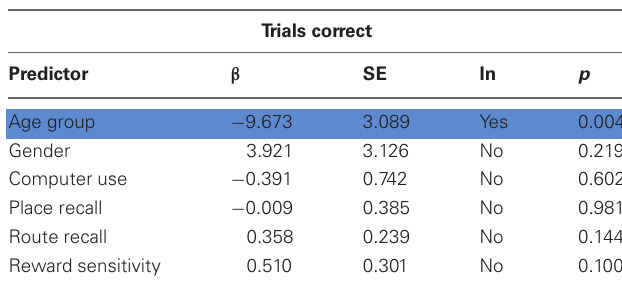
Table 1 | Results of stepwise regression analysis predicting trials correct, with significant predictors (age group) highlighted in blue.